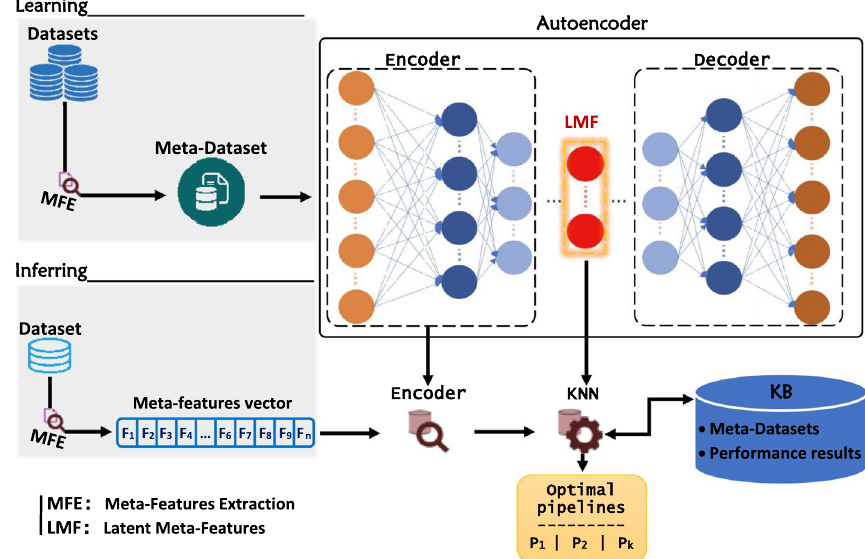
Fig. 3 Overview of proposed AeKNN-based